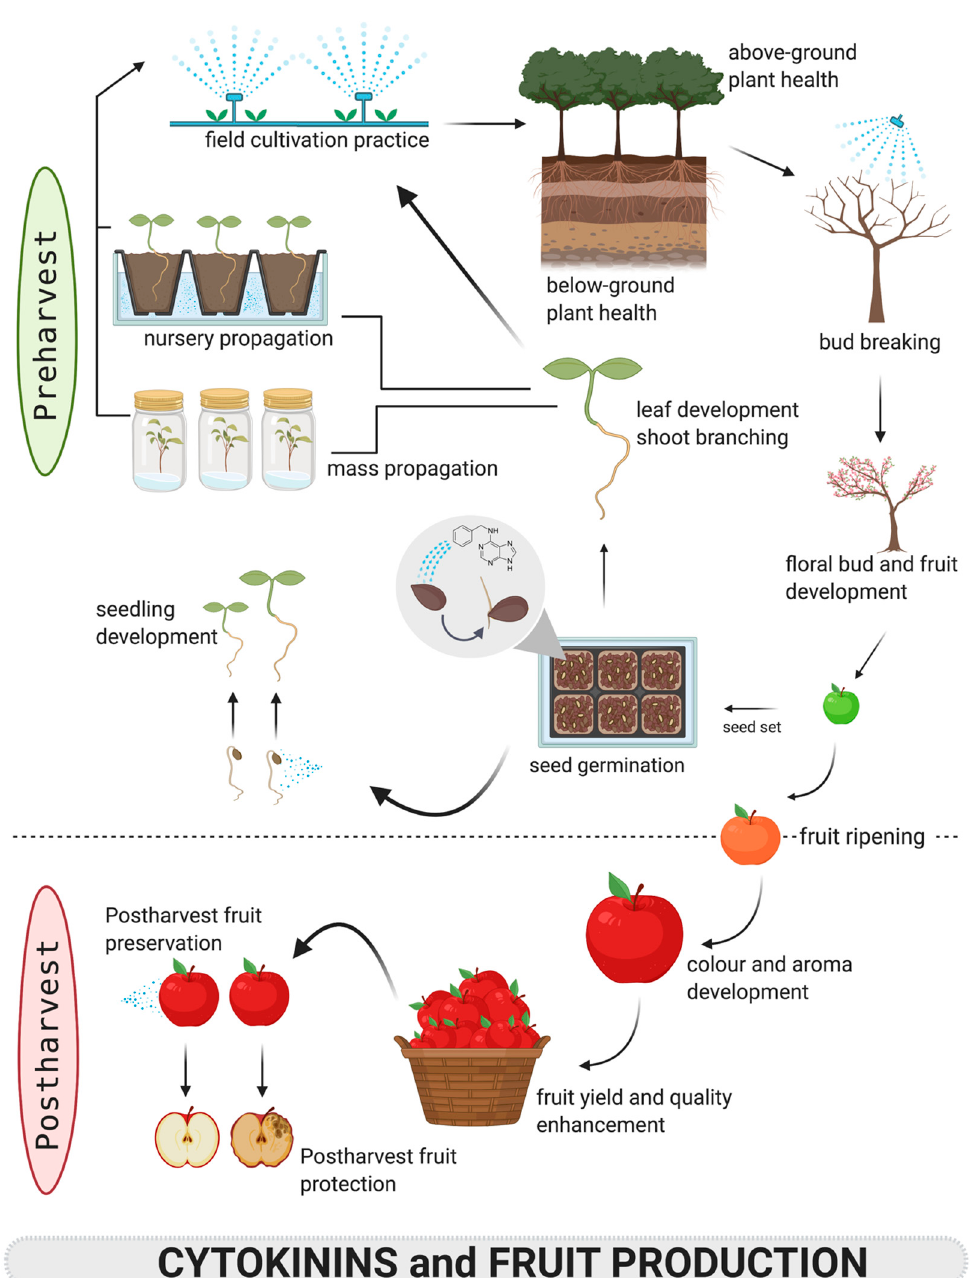
Figure 2. An overview of cytokinin applications in the production of horticultural fruits using apple as an example.